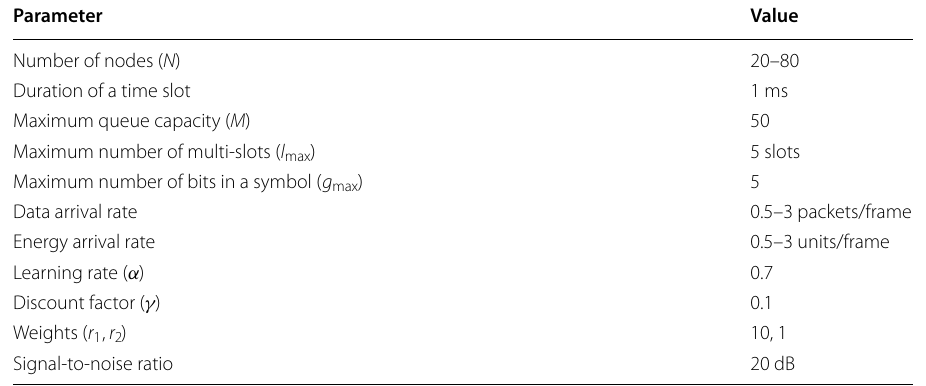
Table 1 Simulation